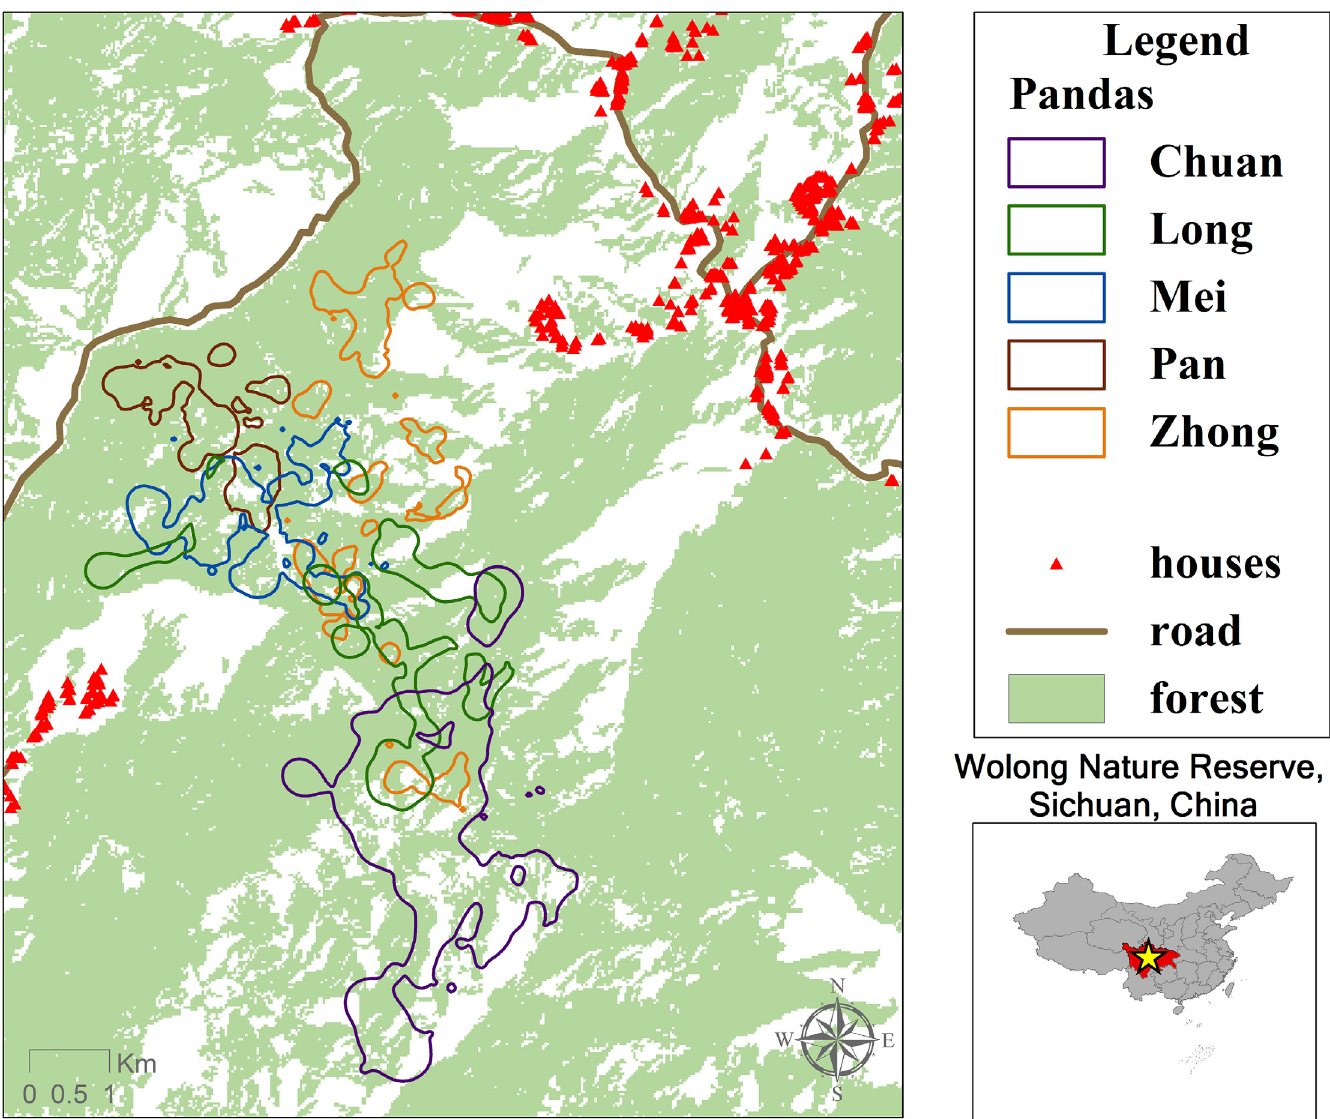
Fig 1. Hetaoping study area for giant panda GPS collar research in Wolong Nature Reserve, China. Forest layer is derived from supervised classification of Landsat TM imagery [43]. Chinese names refer to individual pandas.